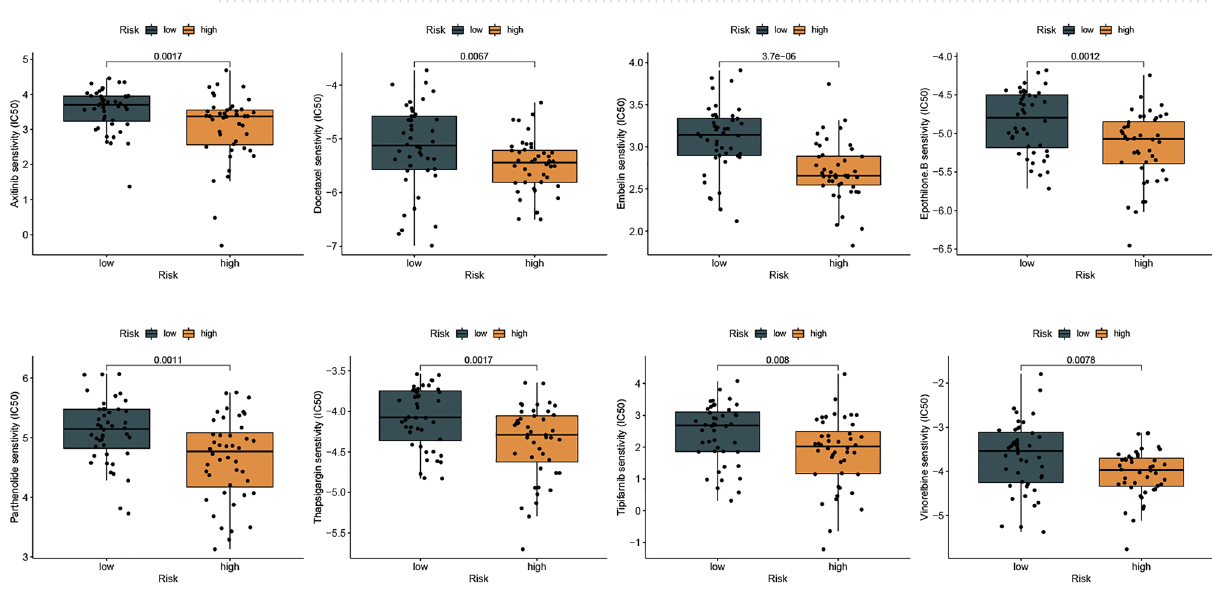
Figure 9. The relationships between low/high-risk groups and chemotherapeutics. Drugs testing is assessed by IC50, such as Axitinib, Docetaxel, Embelin, Epothilone.B, Parthenolide, Thapsigargin, Tipifarnib,